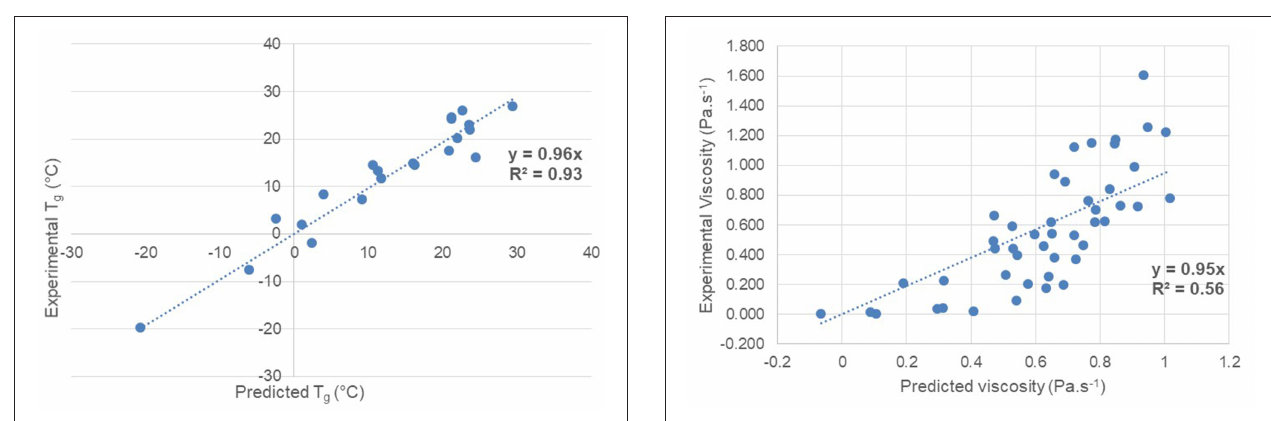
FIGURE 2 | Prediction accuracy of UP viscosity in solution according to the QSPR